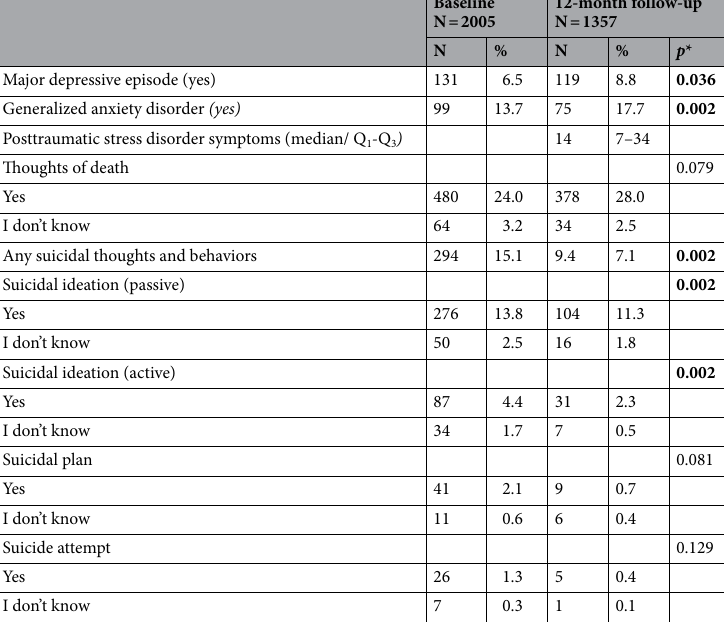
Table 1. Comparison of sample characteristics at baseline and 12-month follow-up samples after weighting. *Categorical variables were assessed with McNemnar’s test, and continuous variables with paired t-test. p -values were adjusted by multiple comparison with False Discovery Rates (FDR). Statistically significant differences between T0 and T1 were conducted only. Kg, Kilograms; Q 1 , First quartile ; Q 3 , Third quartile; SD, Standard deviation. % weighted follow-up sample weight (inverse probability weighting and post- stratification). Significant values are in